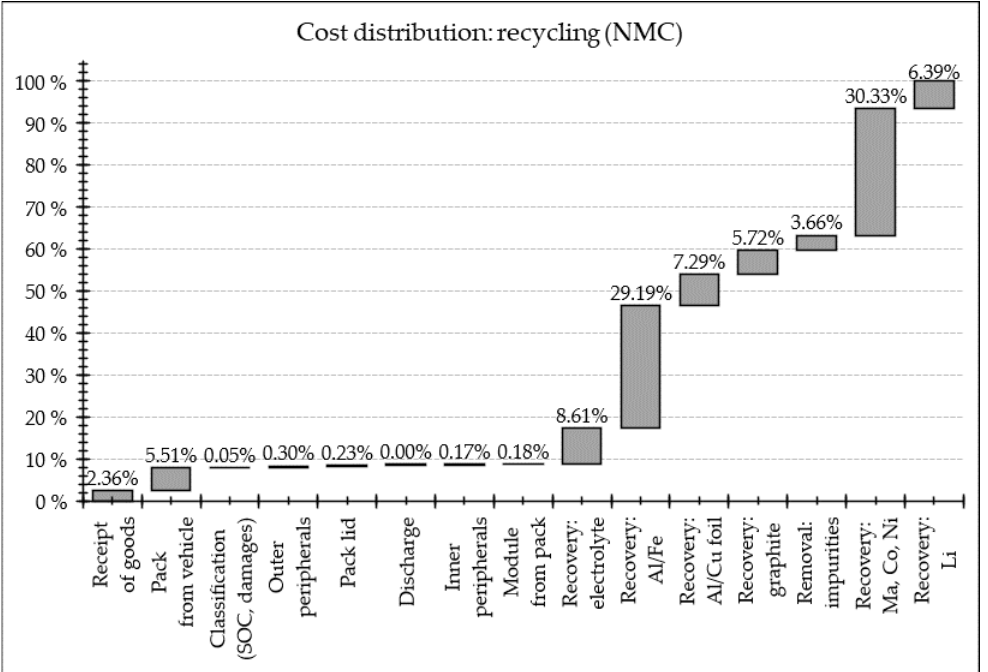
Figure 8. Cost distribution for the recycling (NMC) scenario under standard cost assumptions.